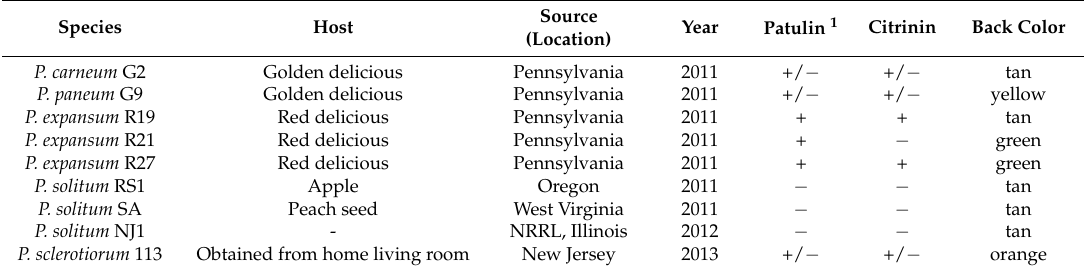
Table 2. Cultural characterization and mycotoxin production of nine blue mold Penicillium isolates.